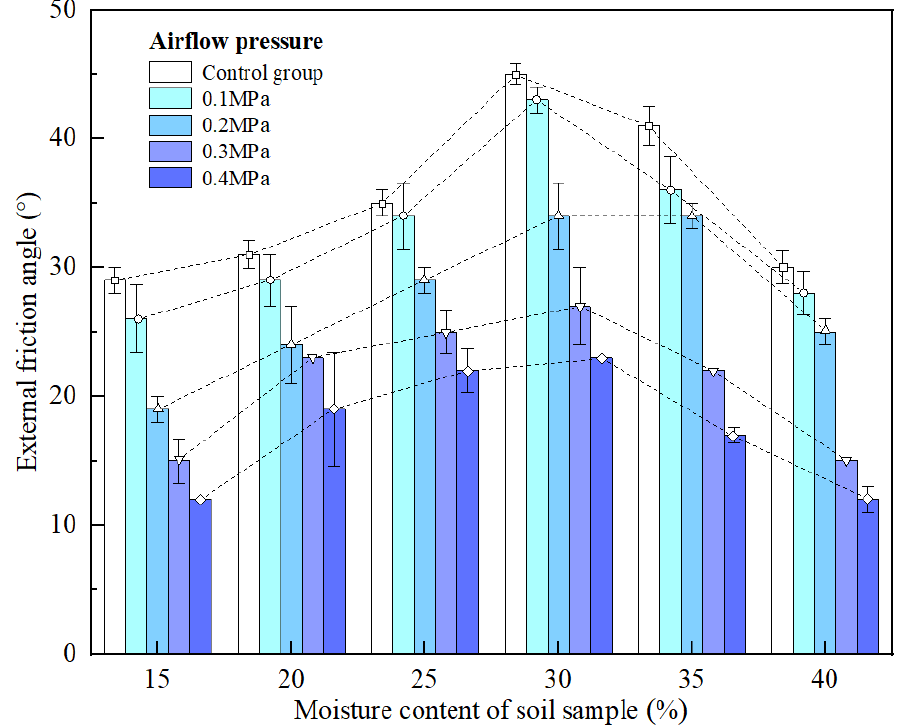
Figure 6. Changes in the external friction angle against airflow at varying